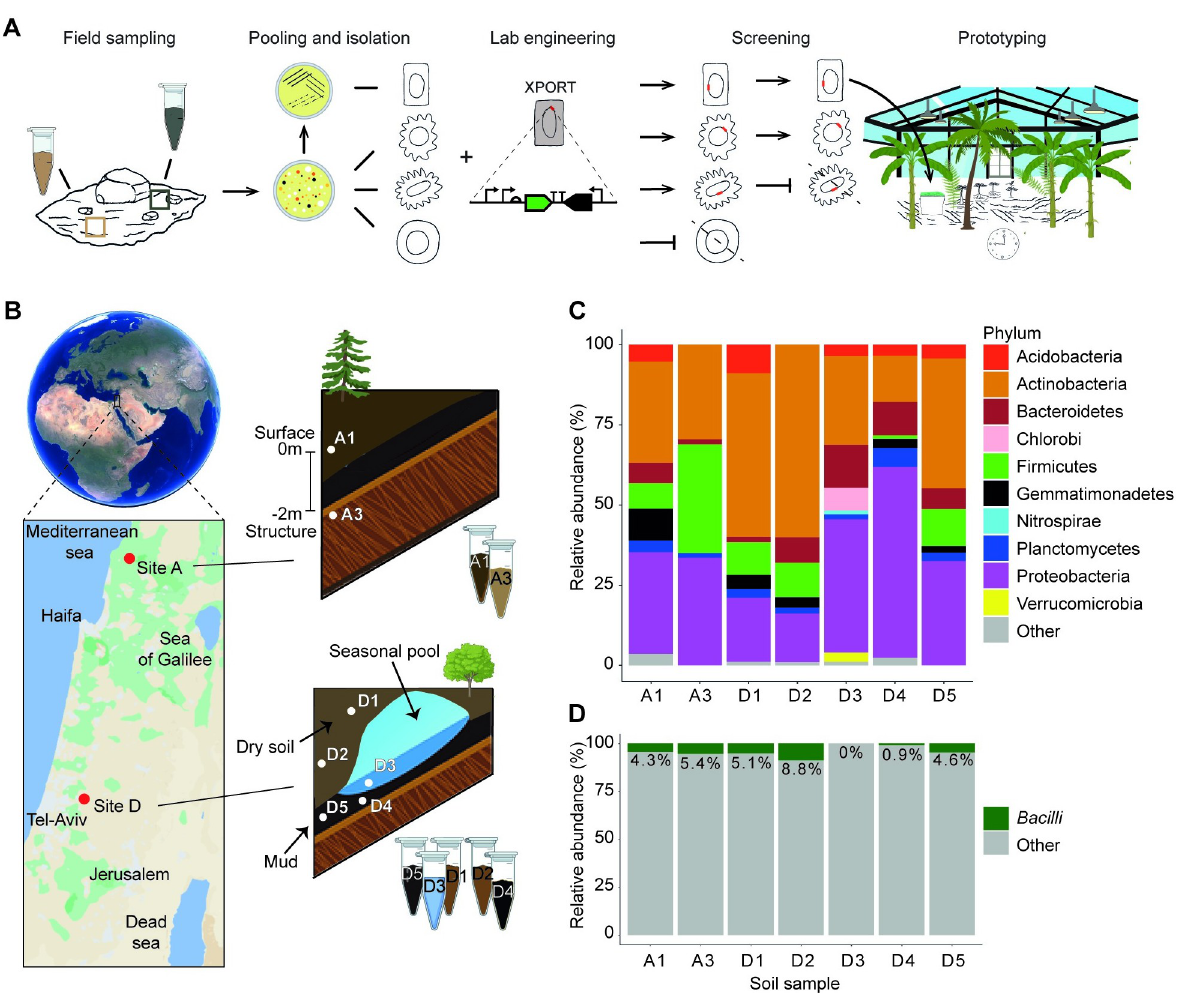
Fig 1. Overview of prototyping strategy and soil samples used. (a) A stepwise schematic of the pipeline developed in this study. (b) Soil sampling locations and types. Approximate locations and the names of the sampling sites are marked in red over a map of the southeastern Mediterranean shore. White dots represent sample types and names. (c) 16S rDNA gene sequencing analysis data of soil samples showing the Phyla-level relative abundance. The ‘Other’ category includes all phyla with relative abundance < 1%. (d) Metagenomic data showing the relative abundance of the Bacilli class in soil